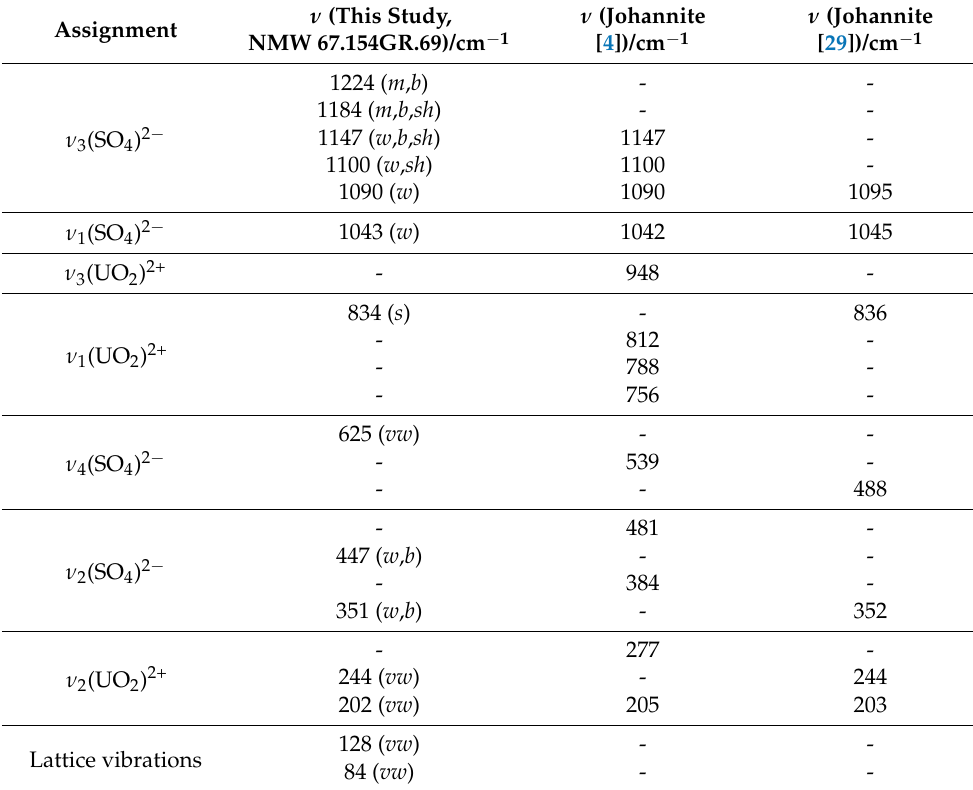
Table 2. Summary of Raman data for johannite with comparisons to the published spectra. Signal intensity is described as strong ( s ), medium ( m ), weak ( w ), and very weak ( vw ) with shoulder and broad peaks represented as sh and b , respectively. The error in the peak position for this study was ± 3 cm − 1 based on the variation between repeats. ν (This Study, ν (Johannite ν (Johannite Assignment NMW 67.154GR.69)/cm − 1 [4])/cm − 1 [29])/cm − 1 1224 ( m , b ) - - 1184 ( m , b , sh ) - - 1147 ( w , b , sh ) 1147 - ν 3 (SO 4 ) 2 − 1100 ( w , sh ) 1100 - 1090 ( w ) 1090 1095 ν 1 (SO 4 ) 2 − 1043 ( w ) 1042 1045 ν 3 (UO 2 ) 2+ - 948 - 834 ( s ) - 836 - 812 - ν 1 (UO 2 ) 2+ - 788 - - 756 - 625 ( vw ) - - - 539 - ν 4 (SO 4 ) 2 − - - 488 - 481 - 447 ( w , b ) - - ν 2 (SO 4 ) 2 − - 384 - 351 ( w , b ) - 352 - 277 - 244 ( vw ) - 244 ν 2 (UO 2 ) 2+ 202 ( vw ) 205 203 128 ( vw ) - - 84 ( vw ) -